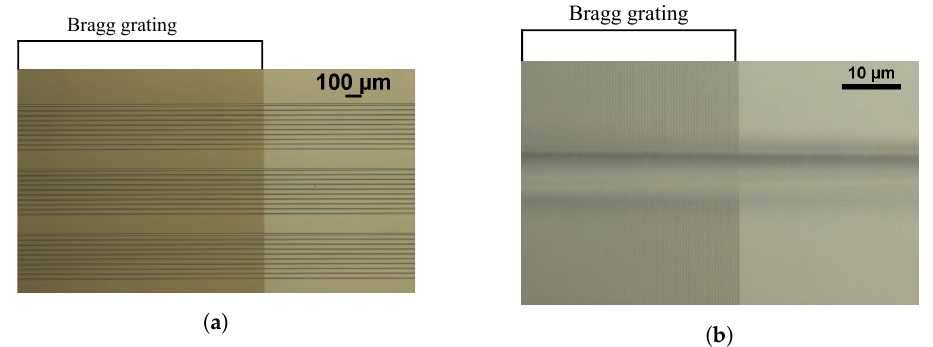
Figure 16. Microscope pictures of the waveguides with the Bragg grating: ( a ) Focus on three sets of waveguides ( b ) focus on the Bragg grating with one waveguide.